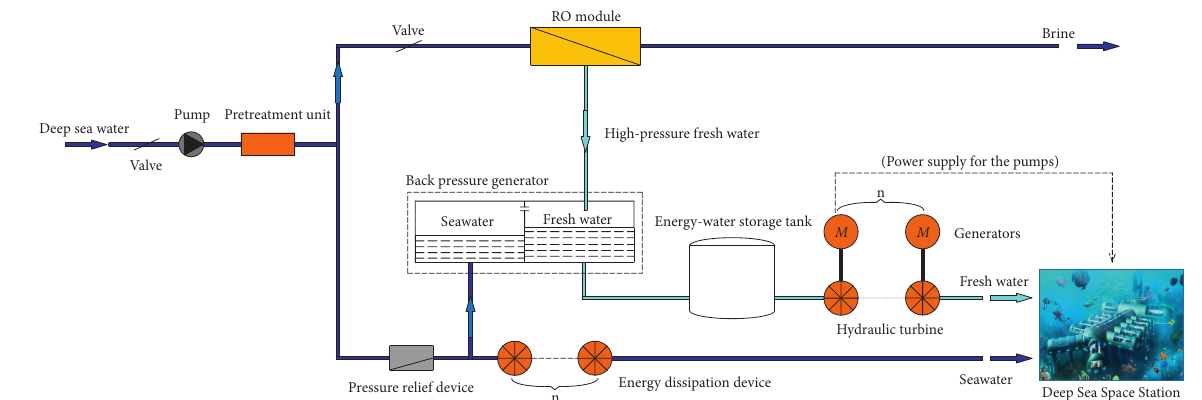
Figure 1: Flow chart of SHP-RO desalination system for large-scale DSSS.